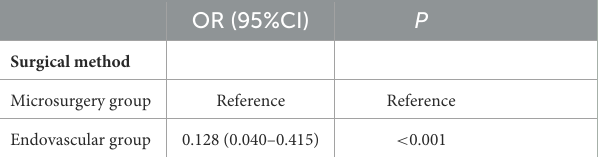
TABLE 3 Results of the multivariable logistic